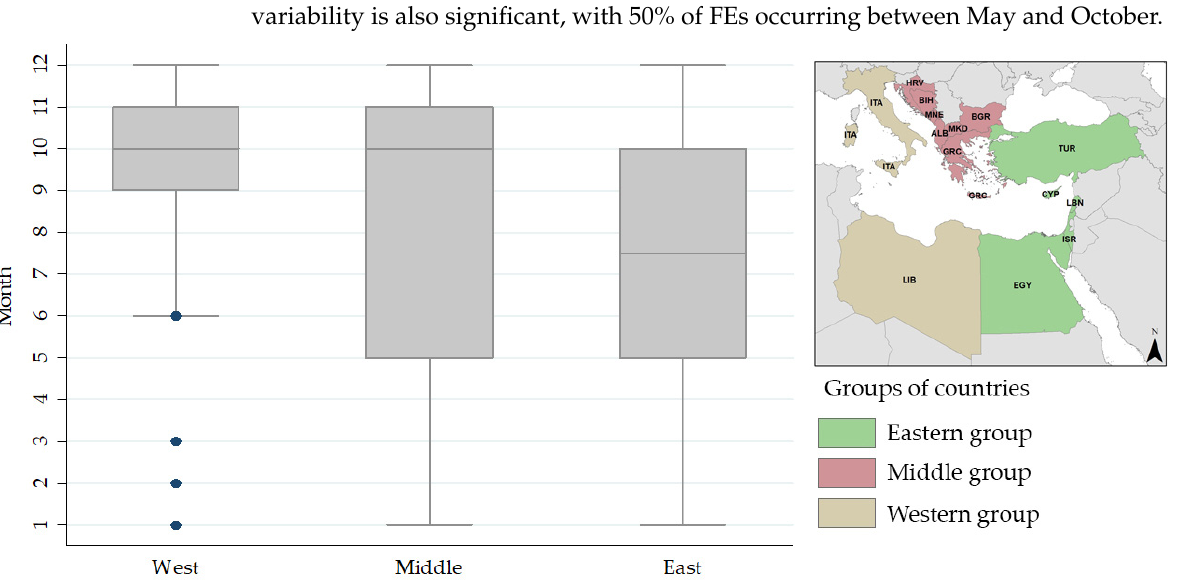
Figure 9. Distribution (boxplot) of monthly occurrences over three geographical regions of the study area: west (ITA, LBY), middle (ALB, BIH, BGR, GRC, MKD, HRV, MNE), and east (CYP, EGY, ISR, LBN, TUR), along with a map illustrating the separation of regions. Blue dots represent outlier events.